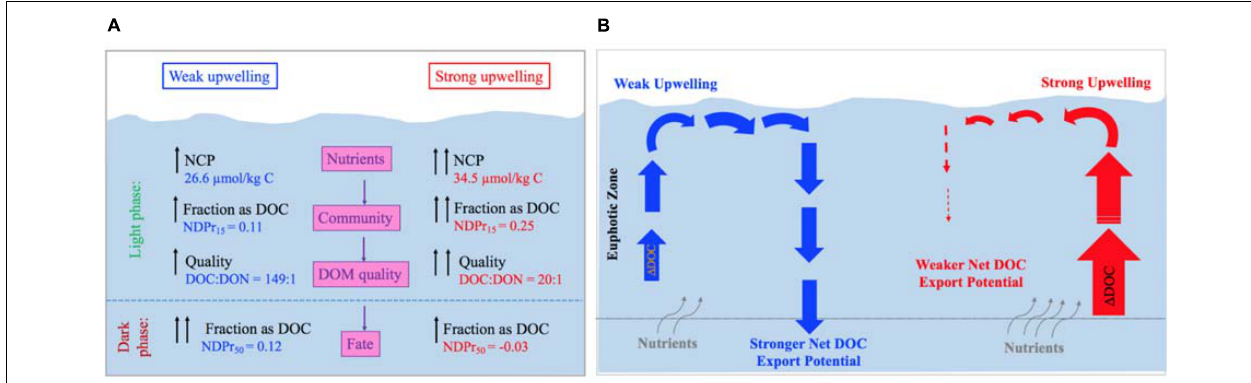
FIGURE 5 | (A) Chart comparing net community production (NCP) and organic matter dynamics in the weak (left side) and strong (right side) upwelling simulations during light and dark phases. Weak upwelling resulted in the production of a DOC fraction that was resistant to heterotrophic consumption, while higher nutrients in the strong upwelling favored net community production of a more labile DOC that was fully consumed over the course of the incubation. Fraction accumulated as DOC =